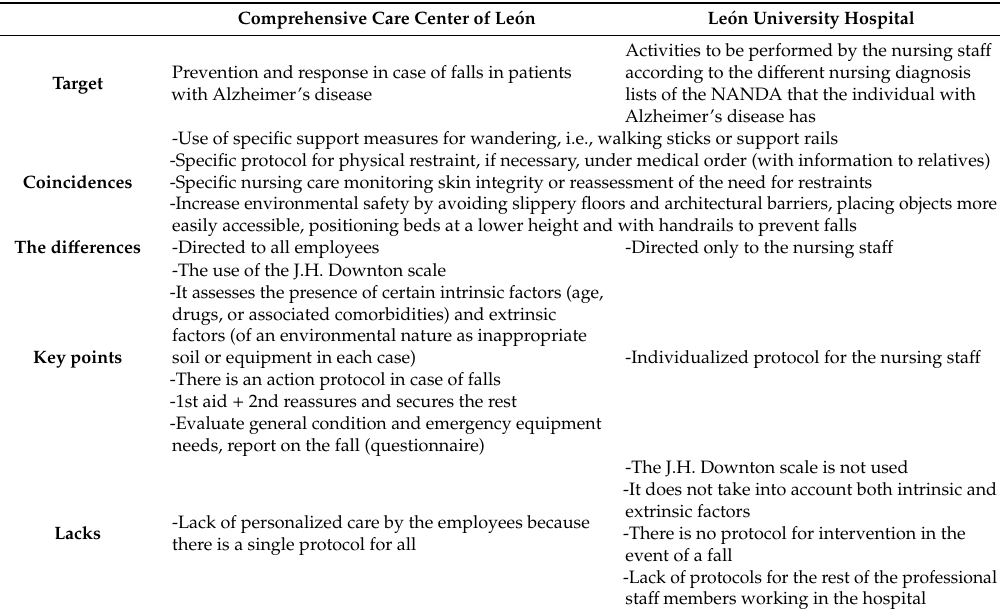
Table 7. Comparative table of the action protocols of Le ó n University Hospital and Alzheimer’s Comprehensive Care Center of Le ó